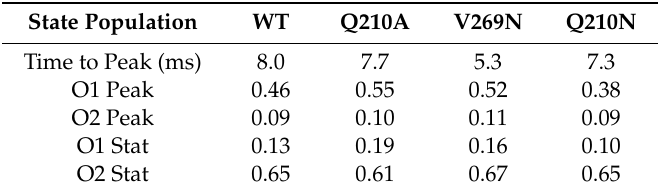
Table 4. State population comparison. The population of O1 and O2 were determined at specific time points as described in the text. Values are shown as a fraction of the maximum occupancy, i.e., O1 + O2 + C1 + C2 = 1.